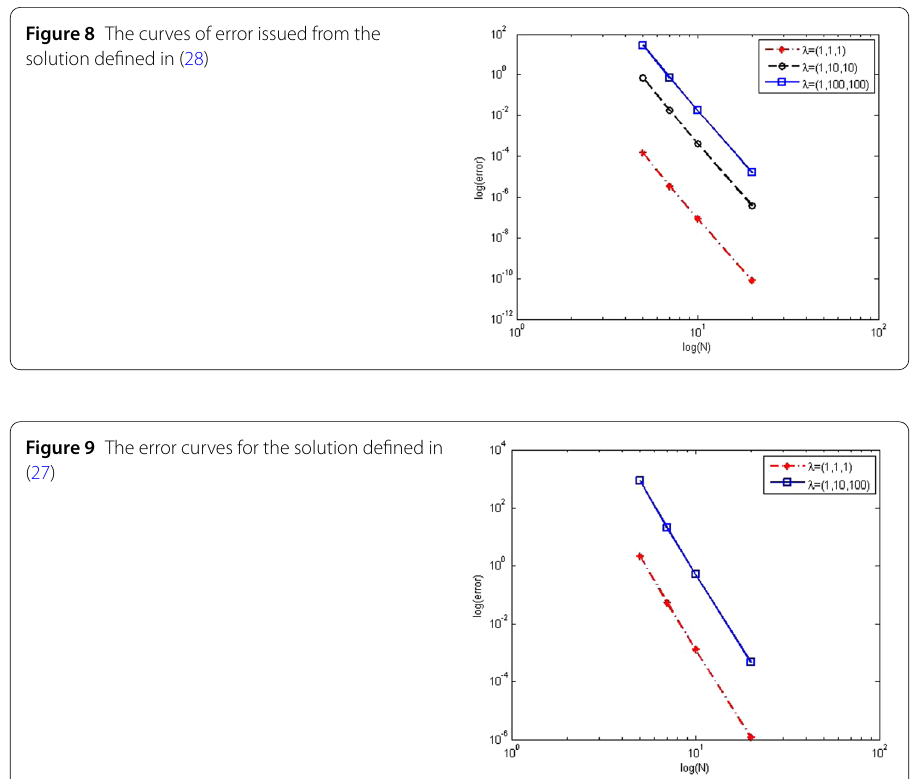
Figure 8 The curves of error issued from the solution defined in (28)